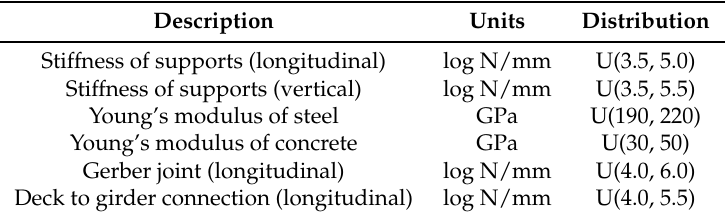
Figure 11. ( a ) Elevation of Crêt de l’Anneau Bridge; and ( b ) cross-section of a typical span, showing the location of deflection sensors placed on Spans II and IV. Table 5. Parameters included in the FE model and their prior probability